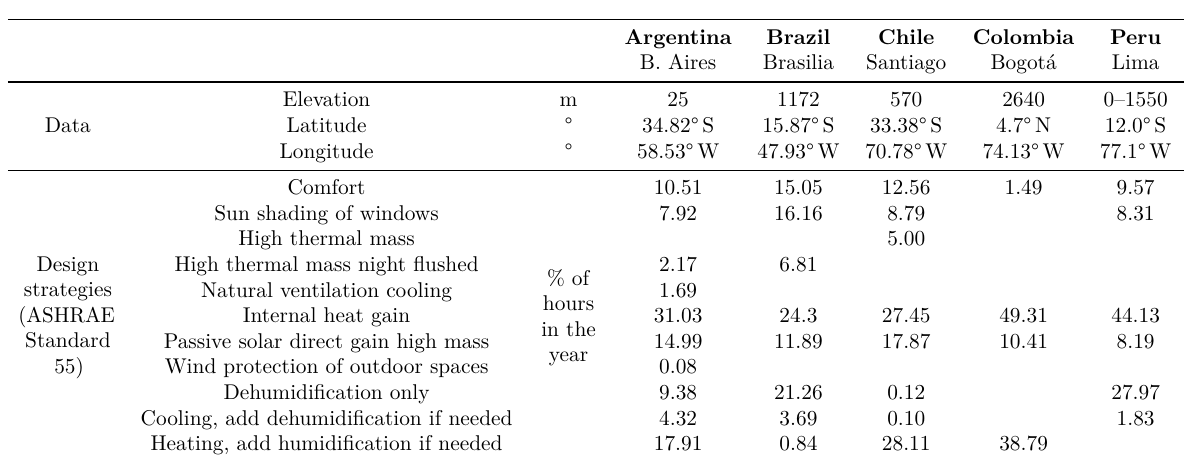
Table 1. Design strategies (ASHRAE standard 55) for 5 Latin American